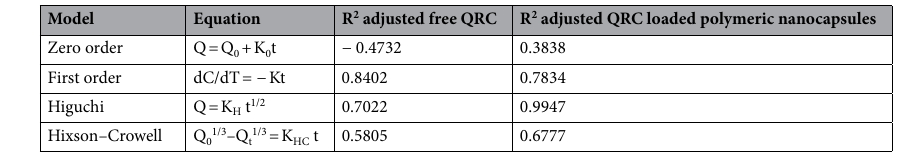
Table 4. Summary of different release models and the corresponding r 2 adjusted. Q is the amount of drug released or dissolved, Q 0 is the initial amount of drug in solution, t is time, K 0 is the zero order release constant, dC is the concentration derivative, dT is the time derivative, K is the first order rate constant, K H is the Higuchi dissolution rate constant, Qt is the remaining weight of solid at time t, K HC is the Hixson–Crowell dissolution rate constant.